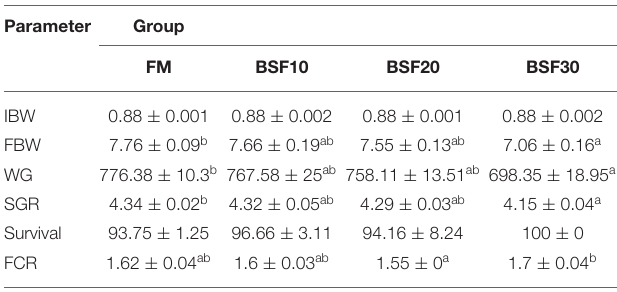
TABLE 6 | The effect of black soldier fly larvae meal (BSF) on intestinal histology of Litopenaeus vannamei .